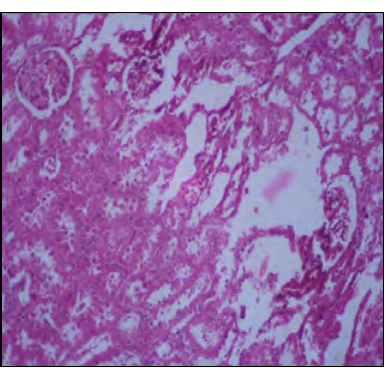
Figure-3. Photomicrograph of kidney showing ruptured glomeruli, severe fatty change, reduced glomerular space and with loss of few glomeruli. H&E X200 (Group